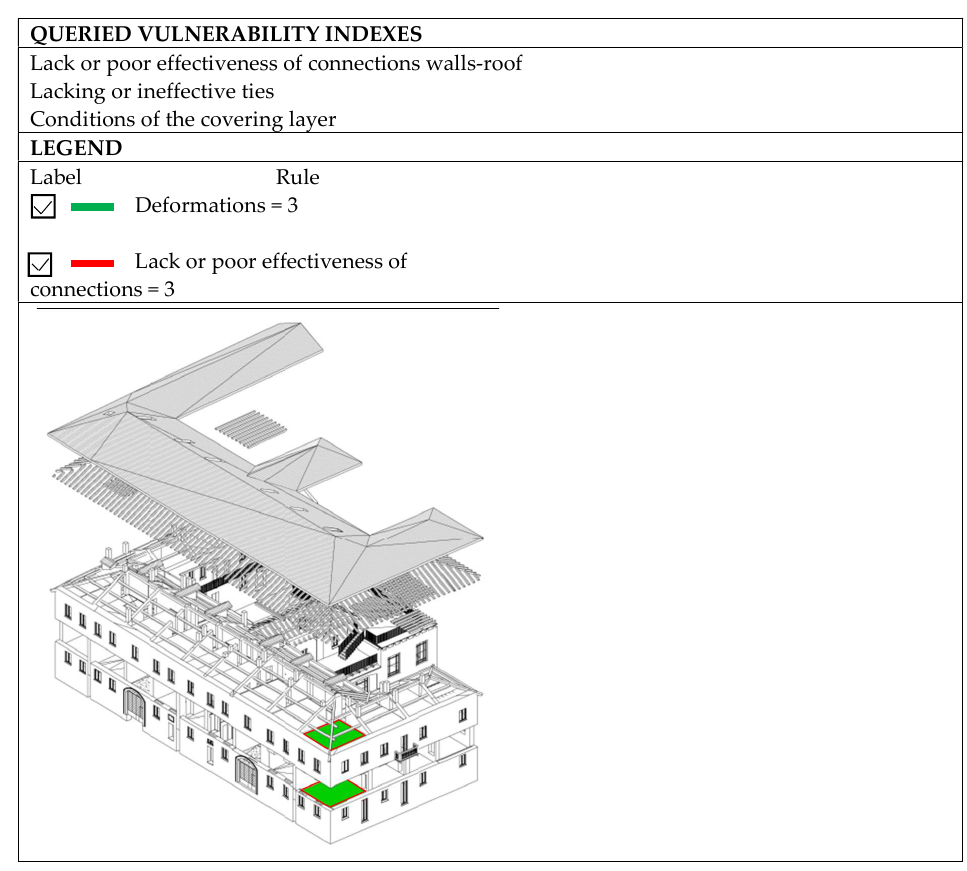
Figure 13. Multiple queries: presence of multiple vulnerabilities with different weights on the same element of the system. The coloring identifies the elements affected by all 2 vulnerabilities in the legend with their weights.